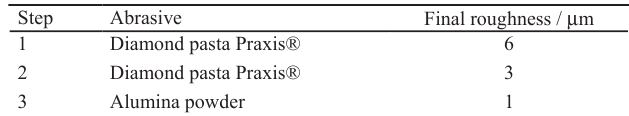
Table 1: Steps for polishing